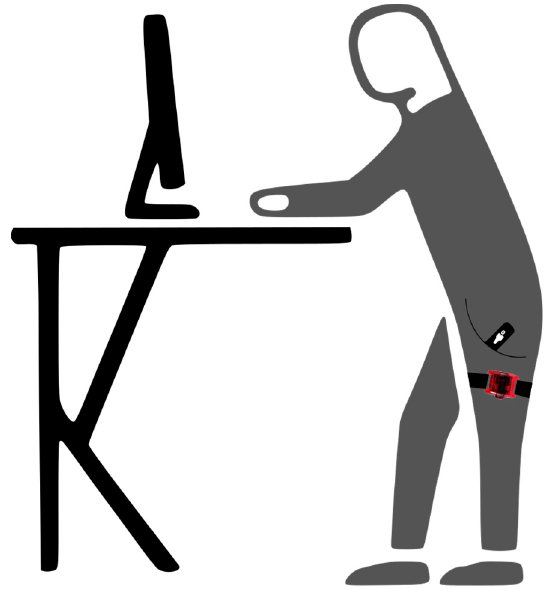
Figure 1. Illustration of wearing locations when wearing both devices simultaneously.